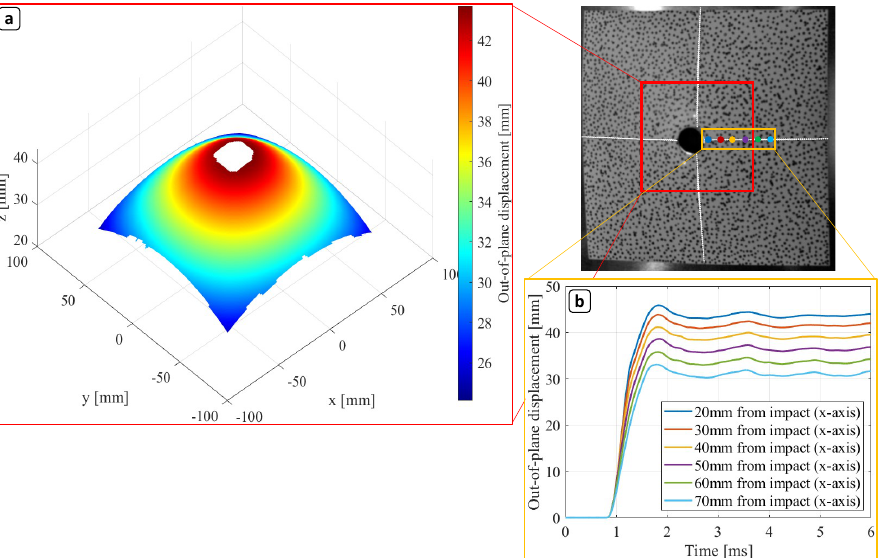
Figure 16. Configuration 2, test 2: ( a ) 3D full-field out-of-plane displacement of permanent defor- mation of blast-loaded aluminum plate previously perforated using a single 12.7 mm FSP; ( b ) out- of-plane displacement history of different points placed at different distances from the center of the impact on the plate.